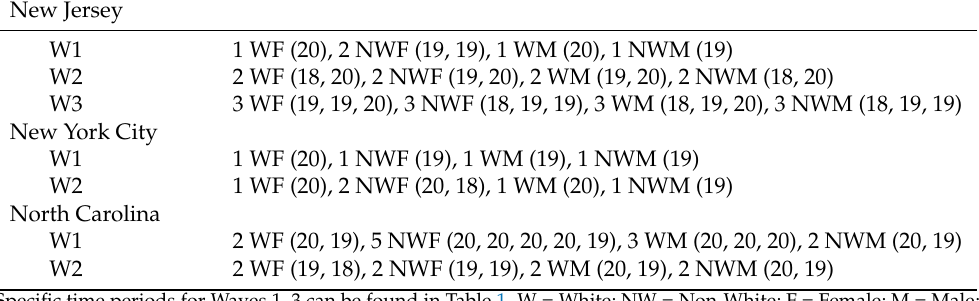
Table 2. Buyer Characteristics by Site and Wave,